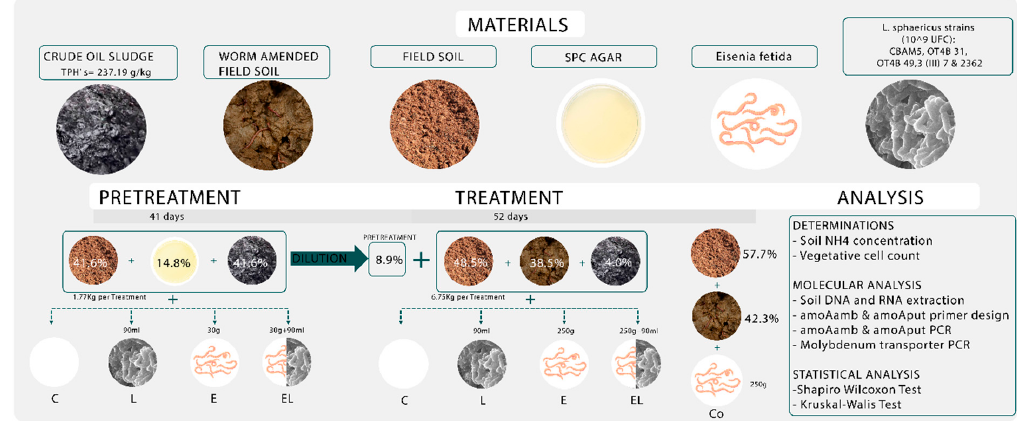
Figure 1. Methodology summary.